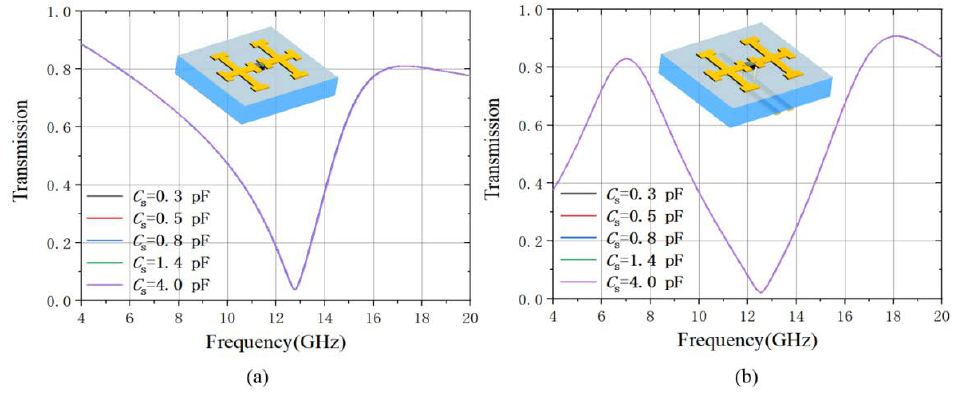
Figure 5. ( a ) the y-polarized transmission of the metamaterial with double-cross and diode unit cell; ( b ) the y-polarized transmission of the metamaterial with double-cross, diode and strip lines unit cell.